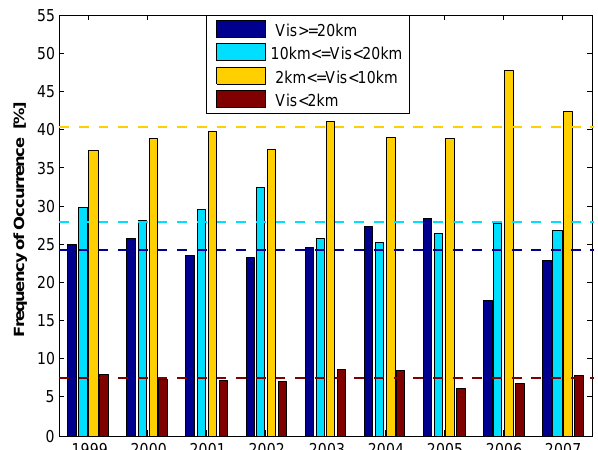
Fig. 2. Occurrence frequency of hourly visibility in different vi- sual ranges from 1999 to 2007. Dashed lines show the 1999–2007 average frequency of visibility in different visual